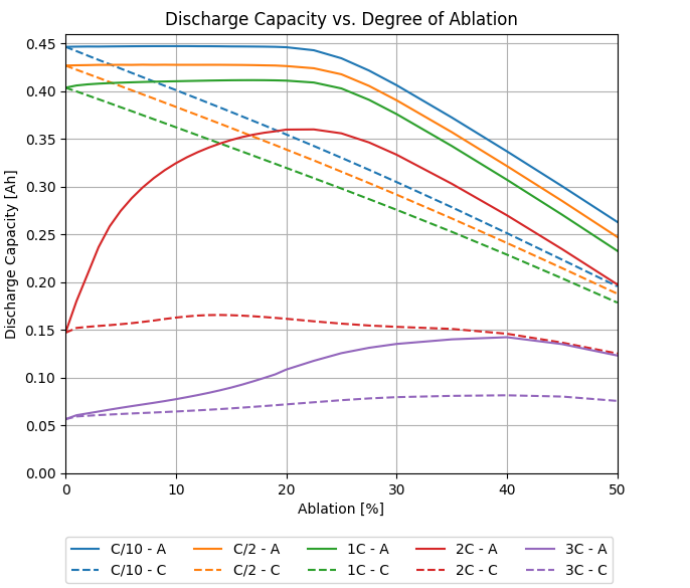
Figure 4. Simulated discharge capacities for full cells for different C-rates, versus the degree of ablation, where (solid) only the anode or (dashed) only the cathode was structured.